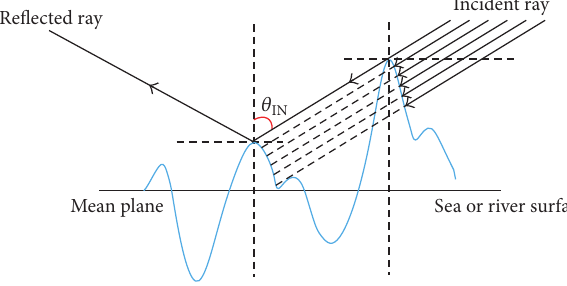
Figure 19: 𝑆 𝑐 as a function of the TX-RX distance ( ℎ = 3.4 ℎ RX